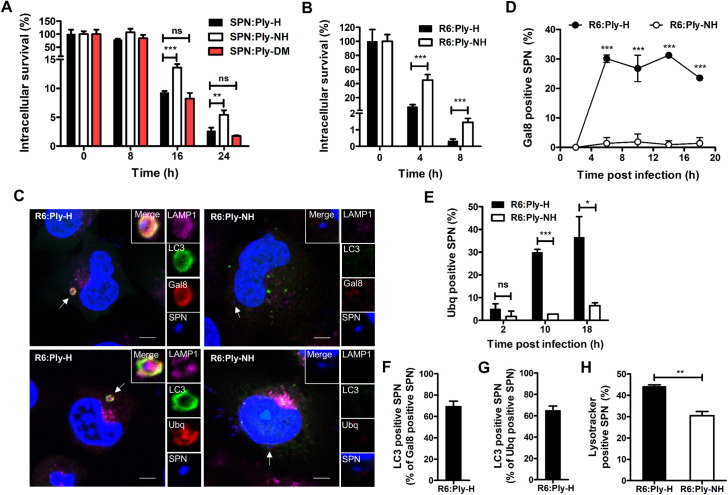
Loss of pore forming ability facilitates prolonged intracellular persistence of SPN.(A) Intracellular survival efficiency of SPN R6 strains expressing either Ply-H, Ply-NH or Ply-DM (H150Y+T172I) in A549s were calculated as percentage survival at indicated time points relative to 0 h. (B) Intracellular survival efficiency of SPN R6 strains expressing either Ply-H or Ply-NH in THP-1 macrophages. (C) Confocal micrographs showing association of SPN (blue) expressing Ply-H or Ply-NH with Gal8 or Ubq (red), LC3 (green) and LAMP1 (pink) in A549s at 10 h.p.i. DAPI (blue) has been used to stain A549 nucleus and SPN DNA. Arrows designate the bacteria shown in insets. Event was localized at z-stack number: 4 out of 7 (for R6:Ply-H_Gal8 image), 4 out of 7 (for R6:Ply-H_Ubq image), 4 out of 8 (for R6:Ply-NH_Gal8 image) and 7 out of 11 (for R6:Ply-NH_Ubq image). Scale bar: 5 μm. (D) Percent co-localization of Gal8 with SPN strains expressing either Ply-H or Ply-NH in A549s at indicated time points post-infection. (E) Percentage co-localization of Ubq with SPN strains expressing either Ply-H or Ply-NH in A549s at indicated time points post-infection. (F-G) Quantification of co-localization of LC3 with Gal8 (F) or Ubq (G) positive R6:Ply-H in A549s at 10 h.p.i. (H) Quantification of co-localization of SPN strains expressing either Ply-H or Ply-NH with Lysotracker in A549s at 18 h.p.i. Data information: Experiments are performed thrice and data of representative experiments are presented as mean ± SD of triplicate wells. n≥100 SPN per coverslip (D-H). Statistical analysis was performed using one-way ANOVA with Tukey’s multiple comparison test (A) and Student’s two-tailed unpaired t-test (B, D-E, H). ns, non-significant; *p<0.05; **p<0.01; ***p<0.001.